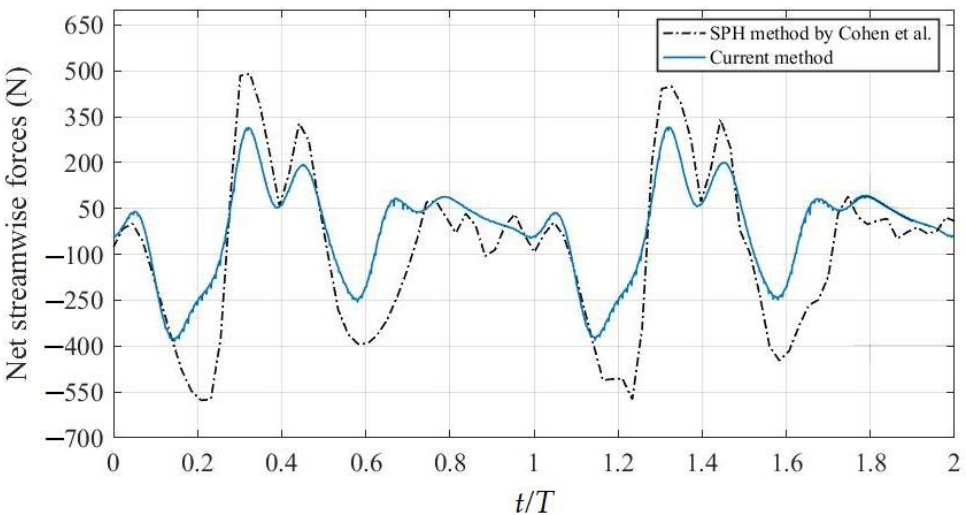
Figure 4. Comparison between the calculated results of this method and the SPH method (Cohen et al. [6]).